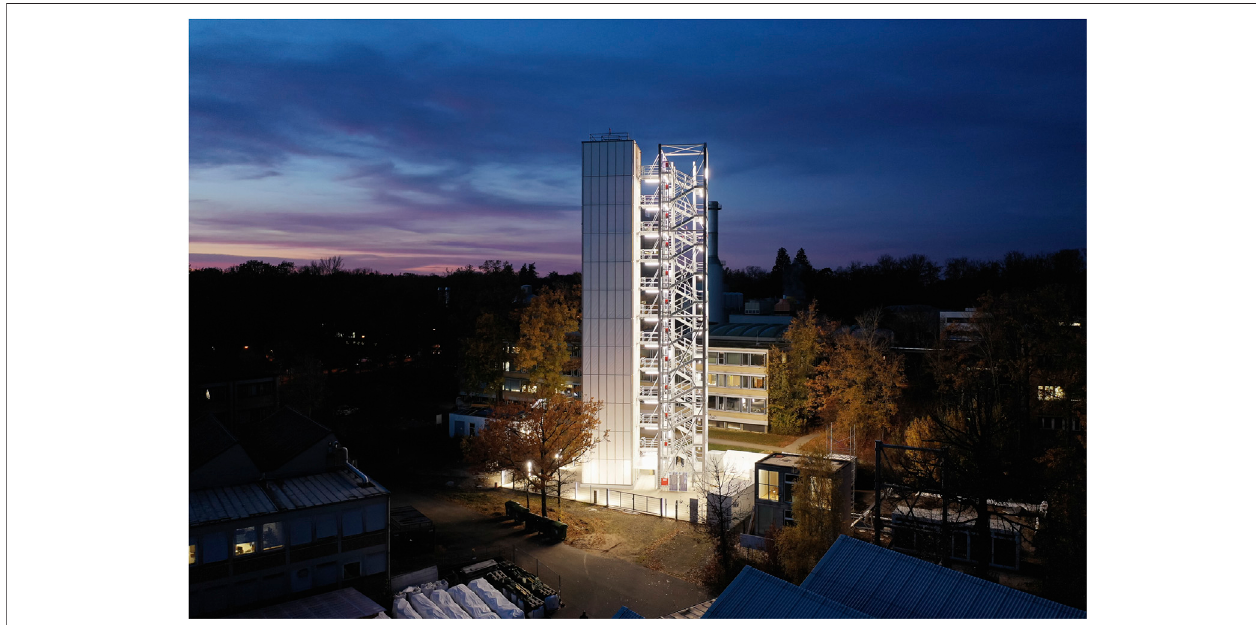
FIGURE 2 | Photography of the fi nalized D1244 in 2021 (source: René Müller).